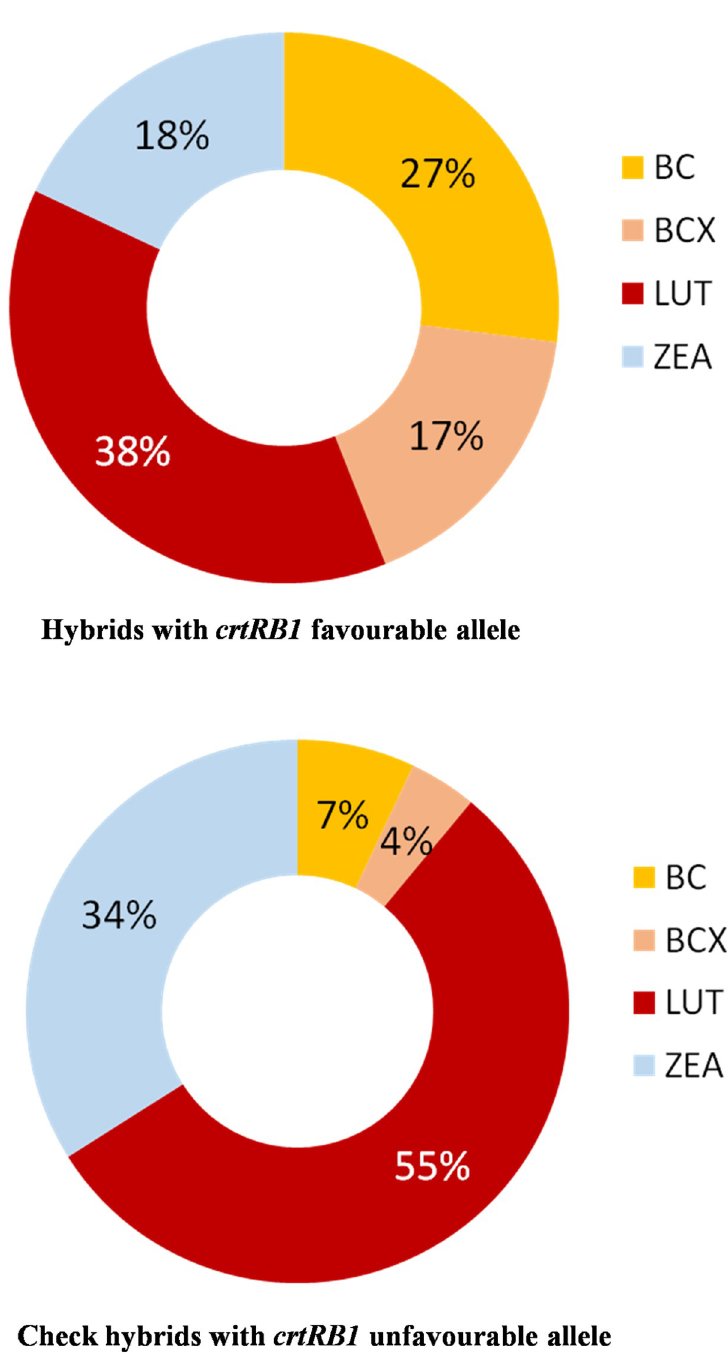
Fig 5. Proportion of carotenoids in hybrids with favourable and unfavourable alleles of crtRB1 . while tester effect was significant for BC, BCX, proA, LUT, non-proA and TC. The interactions of line × tester and environment × crosses were significant for all the carotenoids as well. Environment × line × tester interaction was also found to be significant for all characters except for LUT. On the other hand, environment × tester interaction was significant only for BCX, while environment × line interaction was non-significant for all the characters.